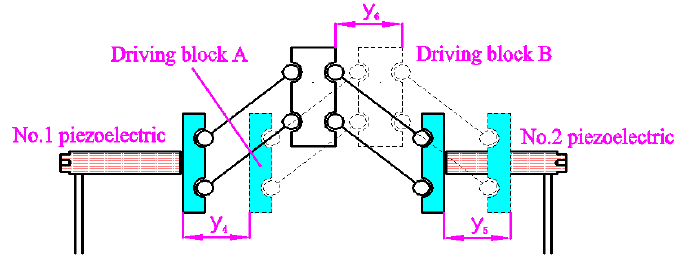
Figure 5. Principle of y -direction motion of 2D motion platform.